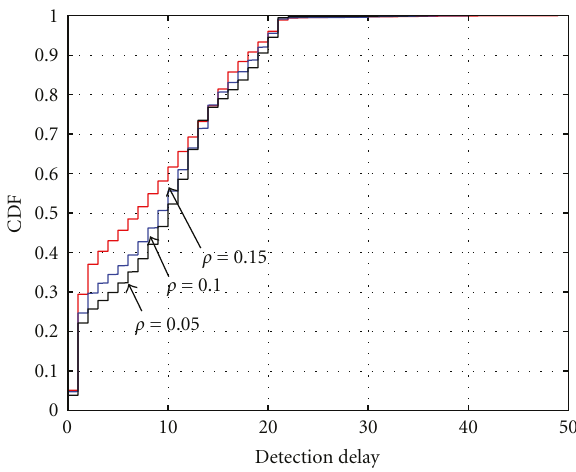
Figure 6: CDF of detection delay for ρ = 0 . 05,0 . 1,0 . 15 when discretized DP is used.